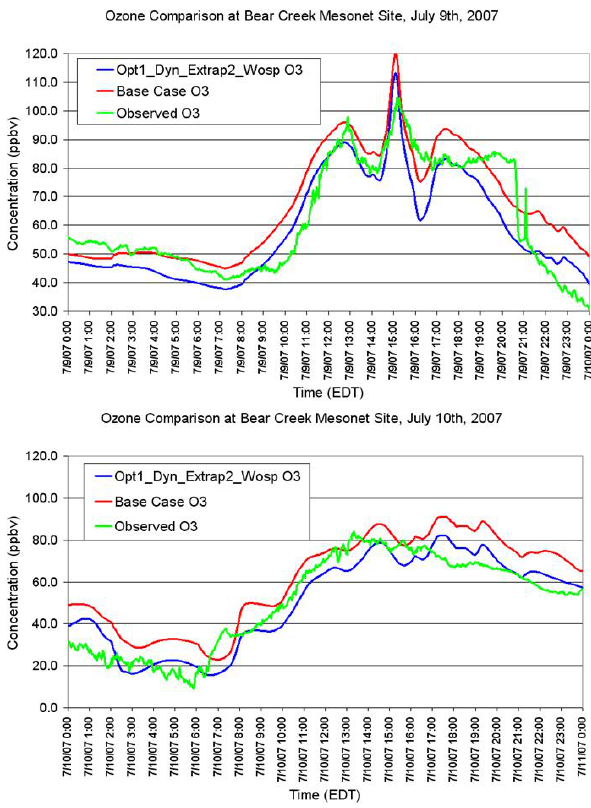
Fig. 9. Example observed (green), Base Case (red), and Opt1 Dyn Extrap2 Wosp (“New”; blue) high resolution simula- tions; (a) 9 July, (b) 10 July.